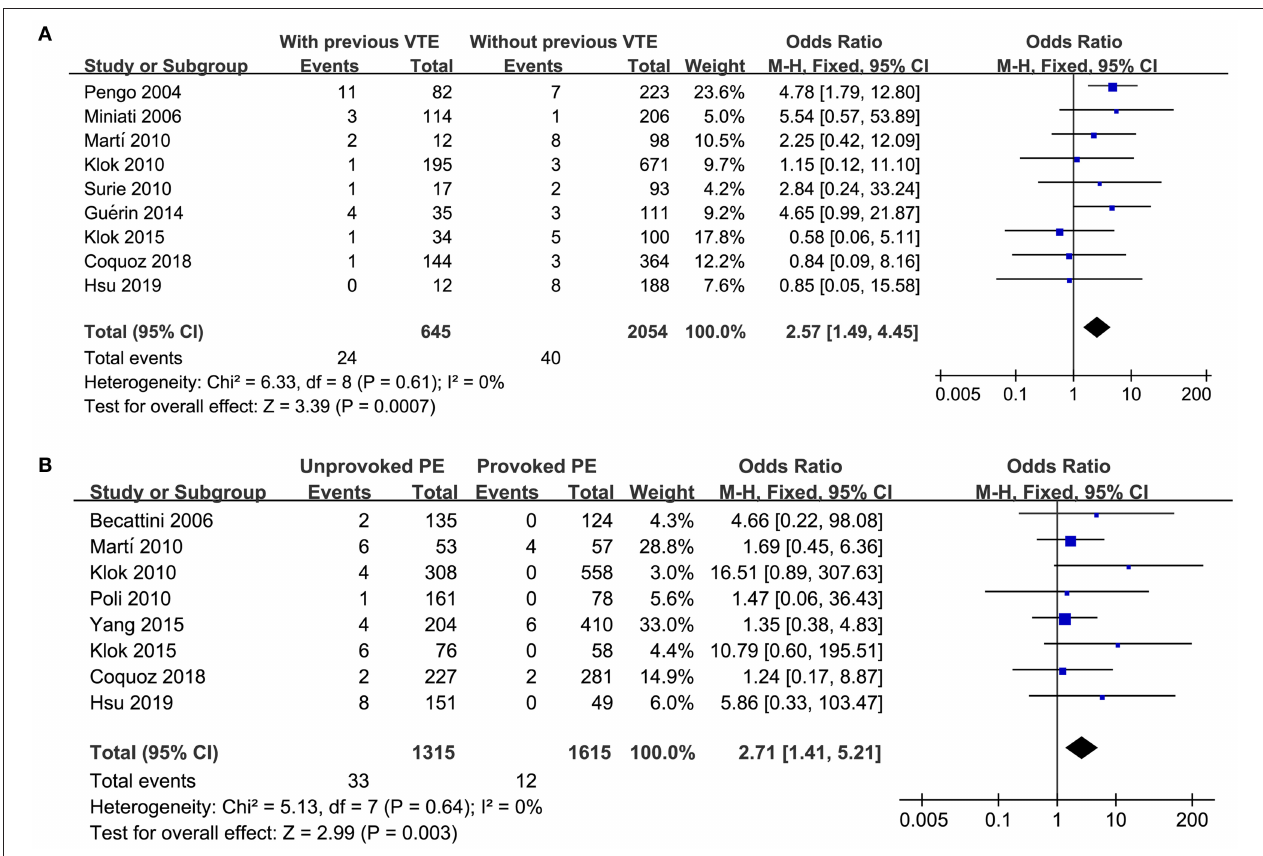
FIGURE 3 | Forest plots for the meta-analysis evaluating the risk of CTEPH in patients with and without previous VTE, and in patients with provoked and unprovoked PE; (A) comparing risk of CTEPH in patients with and without previous VTE; and (B) comparing risk of CTEPH in patients with unprovoked and provoked